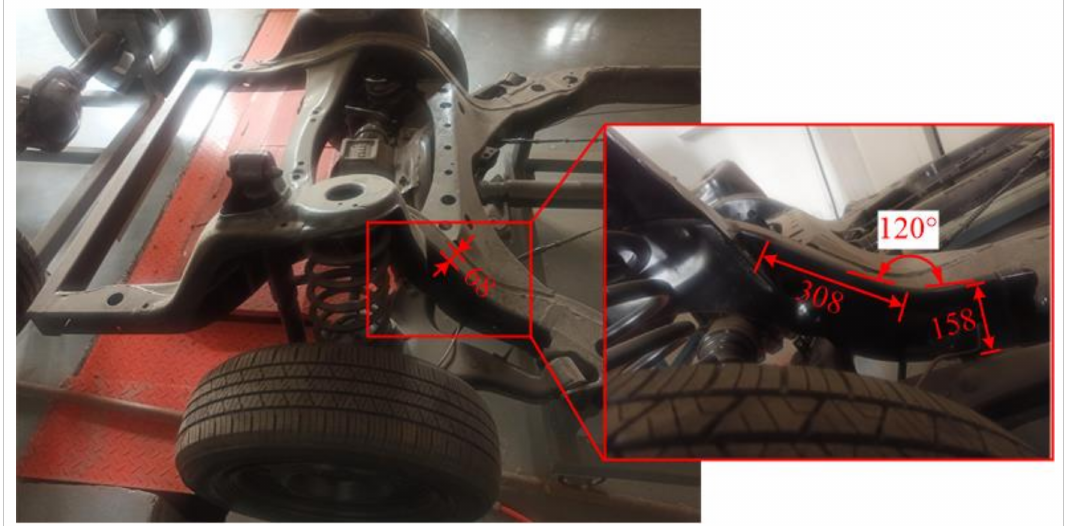
Figure 13. Automobile S-rail